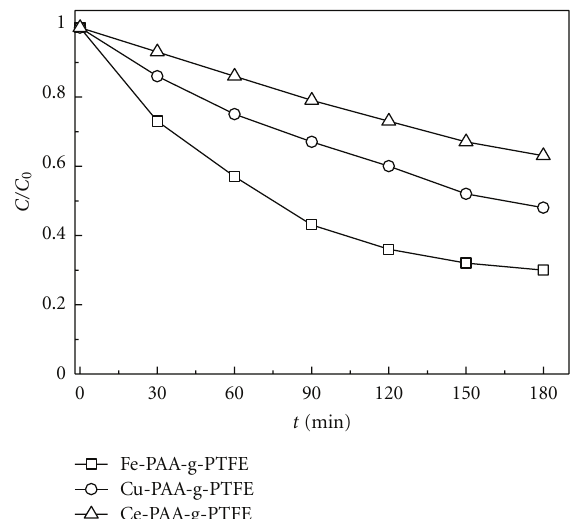
Figure 5: Decomposition of H 2 O 2 in the presence of the di ff erent catalysts.